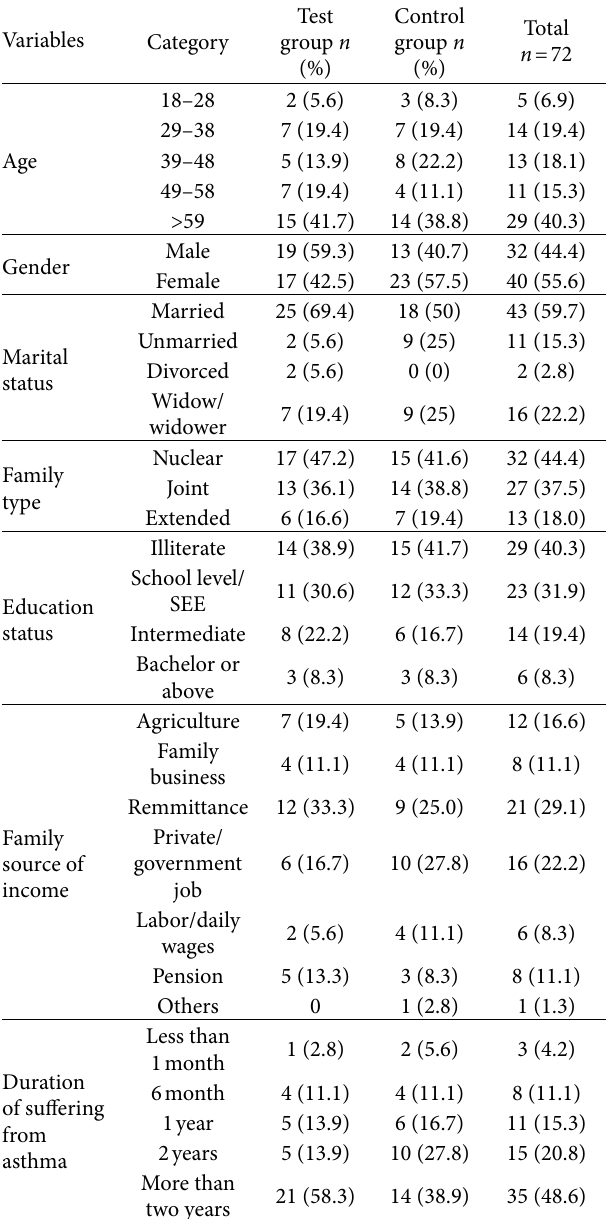
n indicates number of patients and values in the brackets indicate percentage.